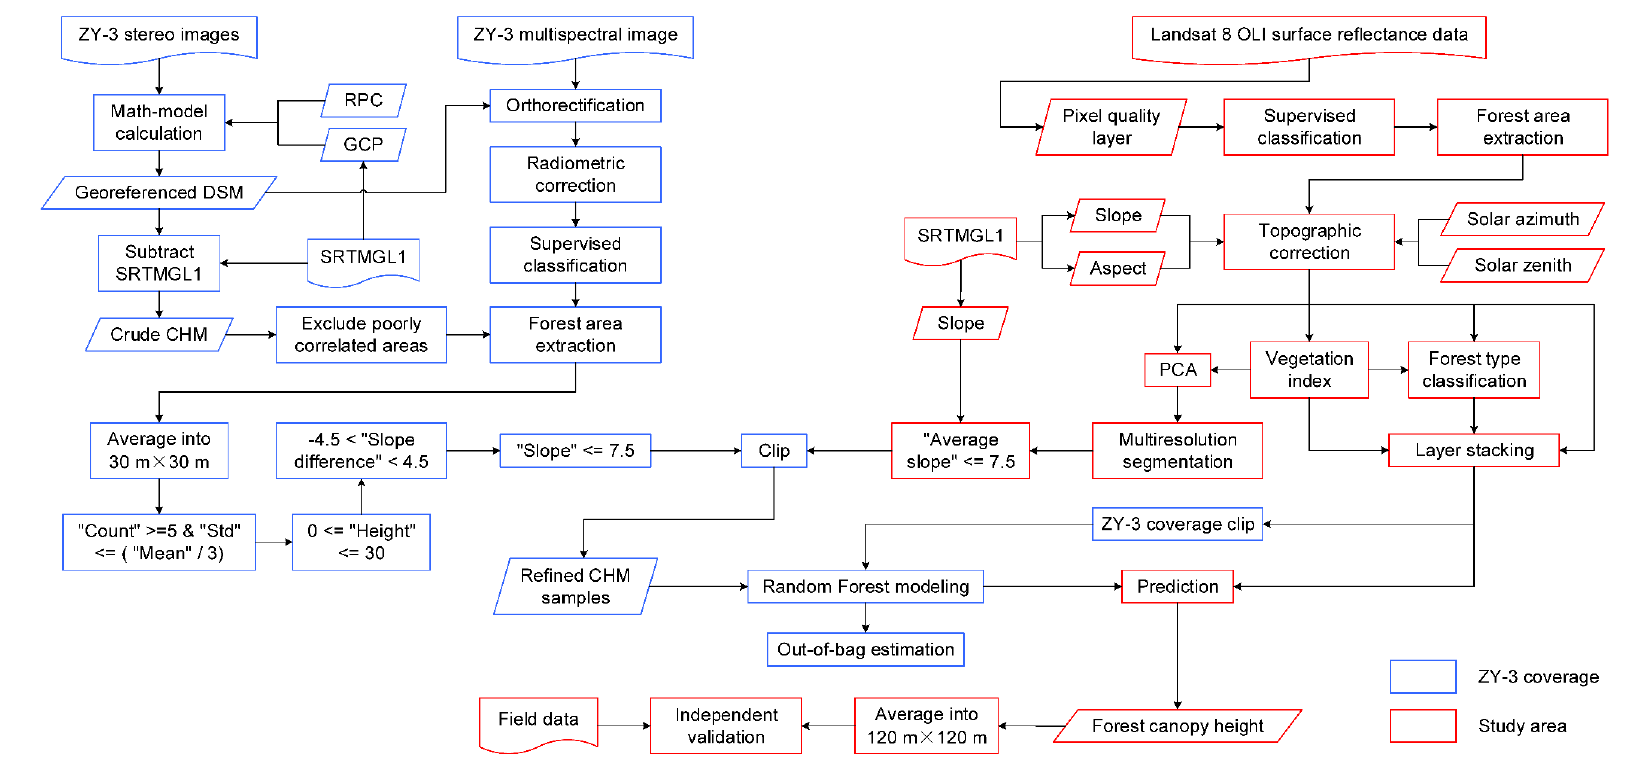
Figure 3. Flow chart of methods. The blue box indicates that the data and operations were based on the ZY-3 coverage. The red box indicates that the data and operations were based on the entire study area. In the flow chart, RPC stands for Rational Polynomial Coefficients files, GCP stands for Ground Control Points, and PCA stands for Principal Component Analysis.